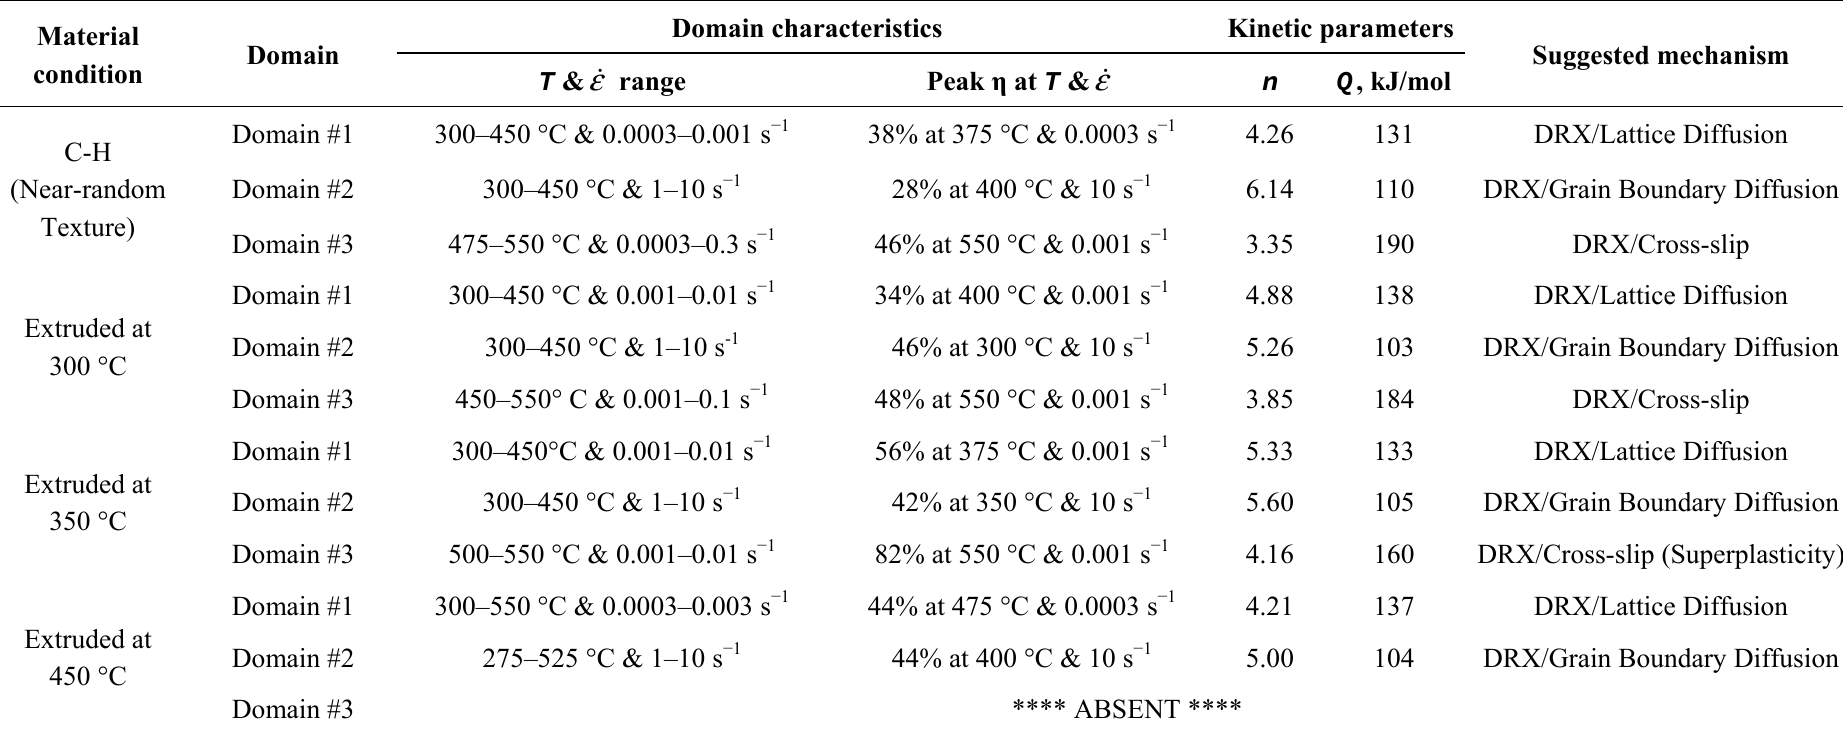
Table 1. Summary of results from processing maps and kinetic analysis of the temperature and strain rate dependence of flow stress in compression for AZ31 alloy in cast-homogenized conditions and after extruding at different